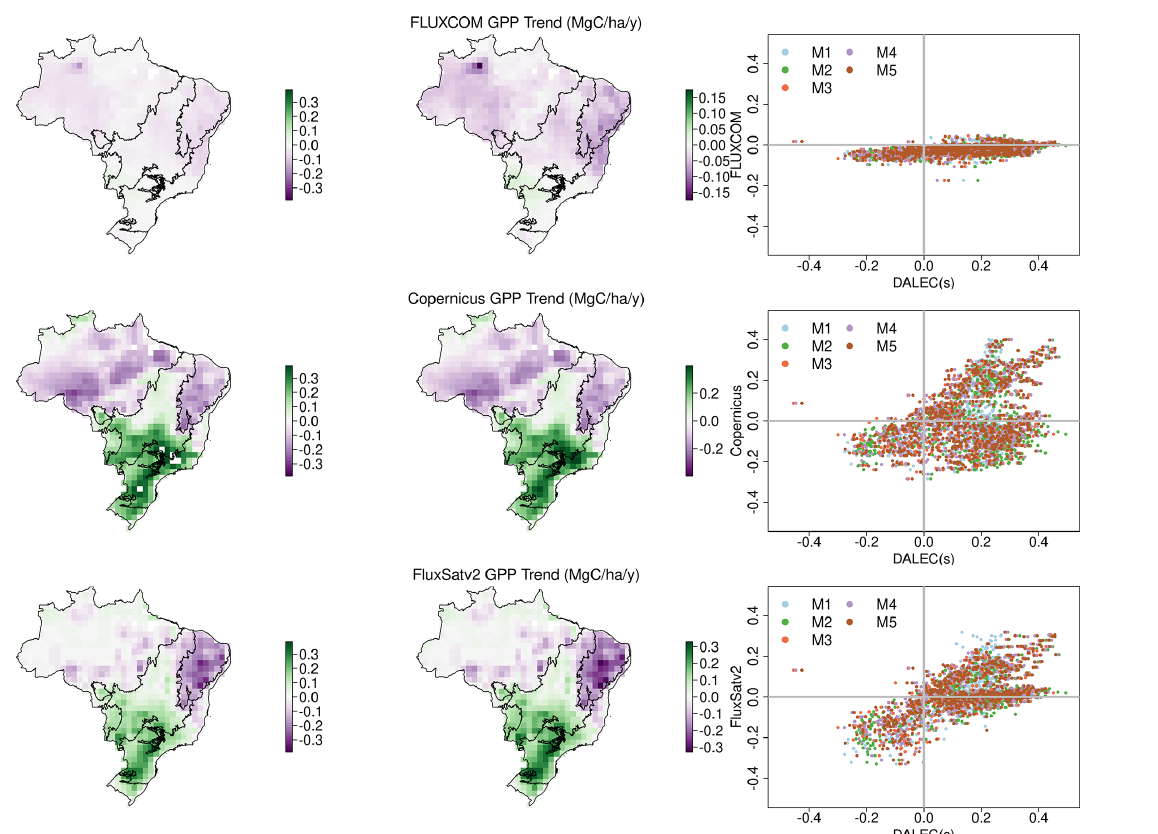
Figure A10. FLUXCOM, Copernicus and FluxSatv2 GPP trends across Brazil (2001–2017). The maps in the left column show the trends on the same axis as the DALEC models in Fig. A9. The middle column shows the same information but on an axis based on values found in each independent estimate only to highlight their spatial patterning. The right column shows a comparison between trend estimates by each